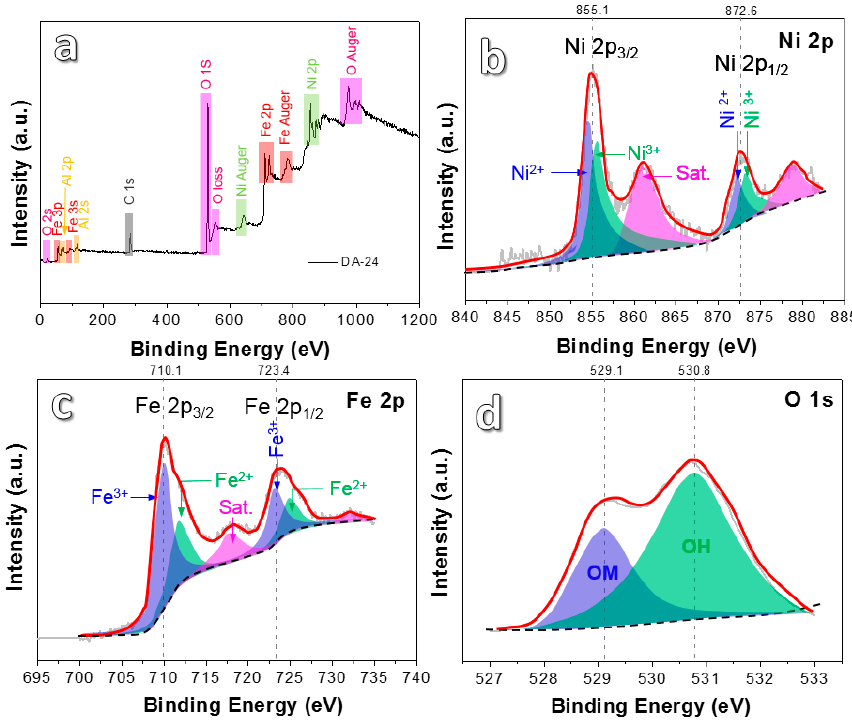
Figure 4. XPS spectra of the Ni 5 Fe 5 Al 90 ribbon dealloyed for 24 h: ( a ) survey spectrum; ( b ) Ni 2p; ( c ) Fe 2p; and ( d ) O 1s.